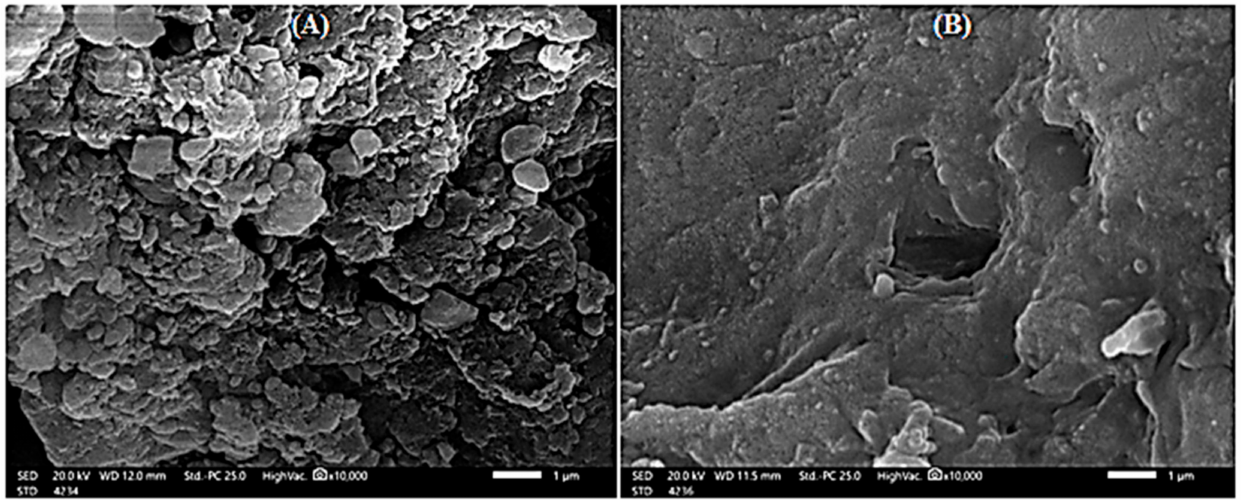
Figure 2. Scanning electron micrograph of P. capillacea nanoparticles before ( A ) and after ( B ) adsorp- tion of IV2R